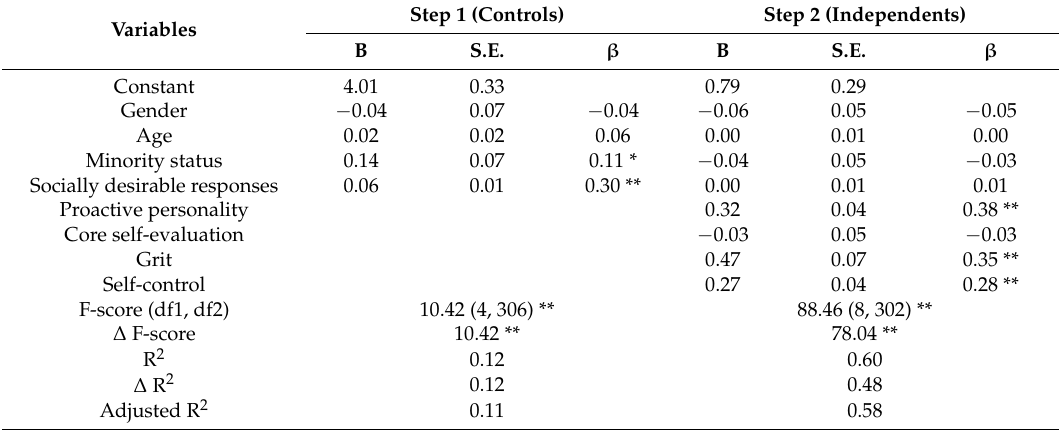
Table 2. Results of Hierarchical Regression Analysis for Predictors of Strategic